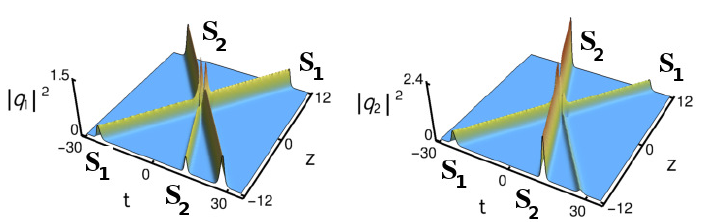
Figure 5. Shape changing collision between a degenerate and nondegenerate soliton: k 1 = l 1 = 1 + i , k 2 = 1 − i , l 2 = 1.5 − 0.5 i , α